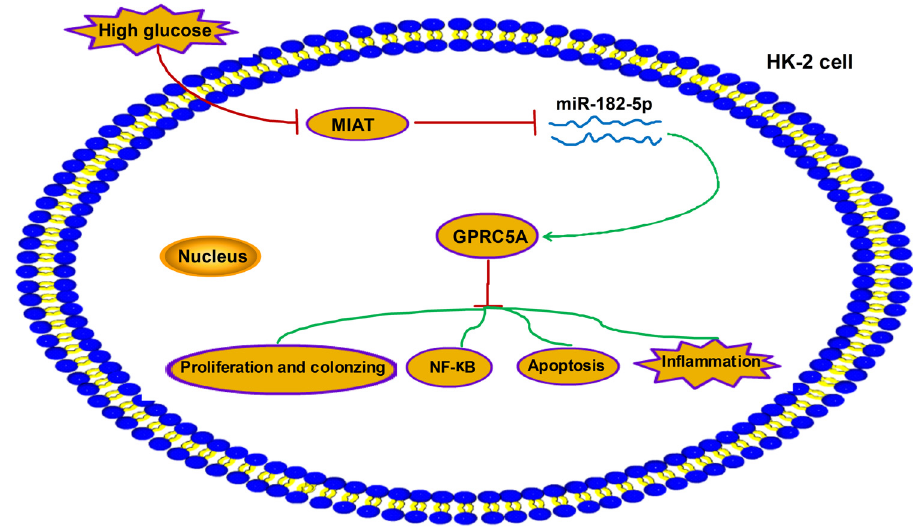
Figure 7: MIAT regulated the HG - induced e ff ects on cell proliferation, colonizing, apoptosis, and in fl ammation via the miR - 182 - 5p/GPRC5A - mediated NF - κ B